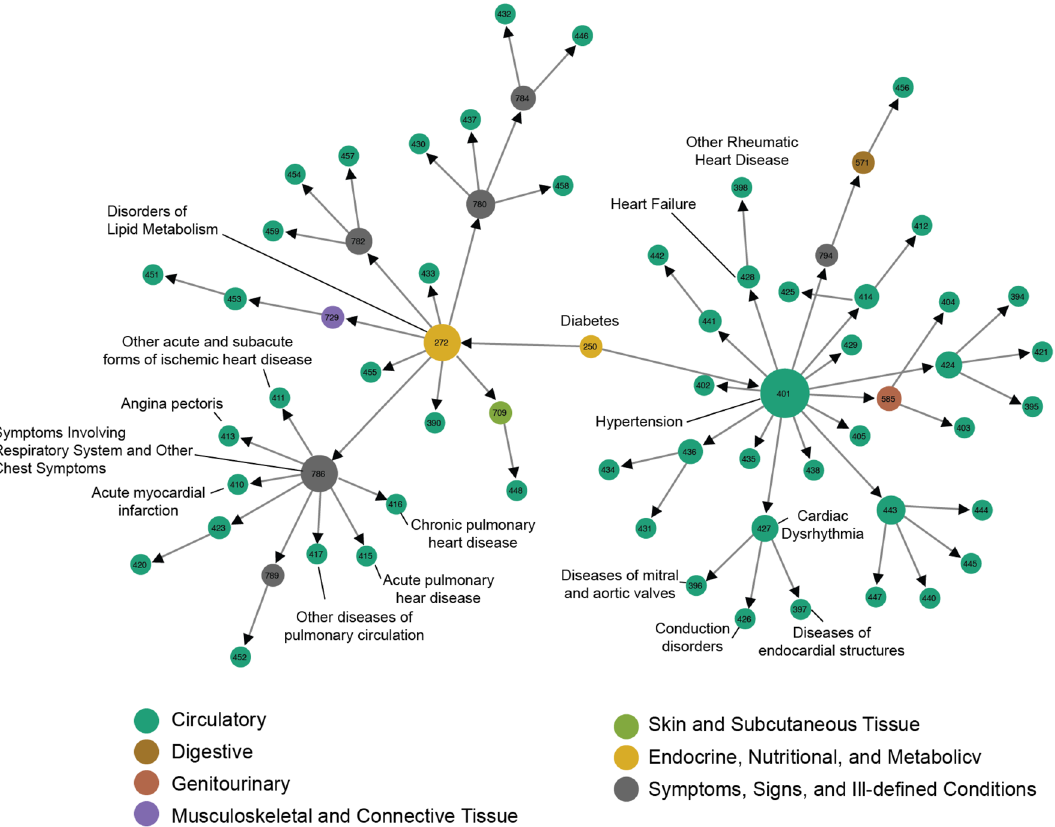
Figure 4. Disease Trajectories. Trajectories connecting diabetes mellitus to all diseases in the ICD-9 chapter “Diseases Of The Circulatory